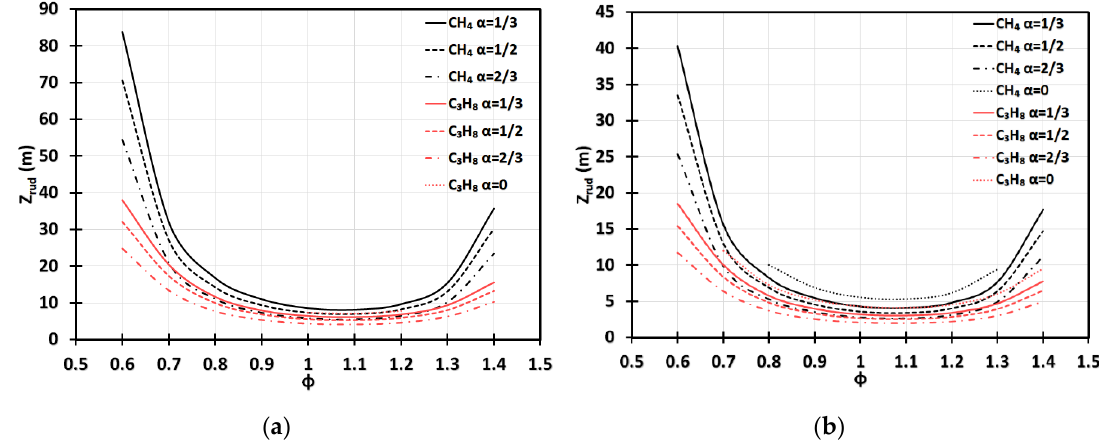
Figure 10. The flame run-up distance versus the equivalence ratio φ for CH 4 -air and C 3 H 8 -air burning at various blockage ratios: α = 0,1/3,1/2,2/3 in a 2D ( a ) and cylindrical-axisymmetric ( b ) geometries.